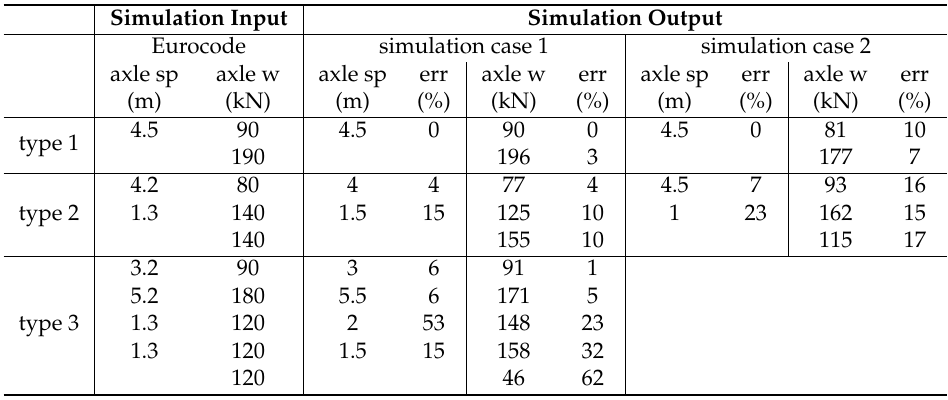
Table 2. WIM simulation inputs and outputs, listing results for the estimation of axle spacings (axle sp) and axle weights (axle w), along with the percentage estimation error (err)).